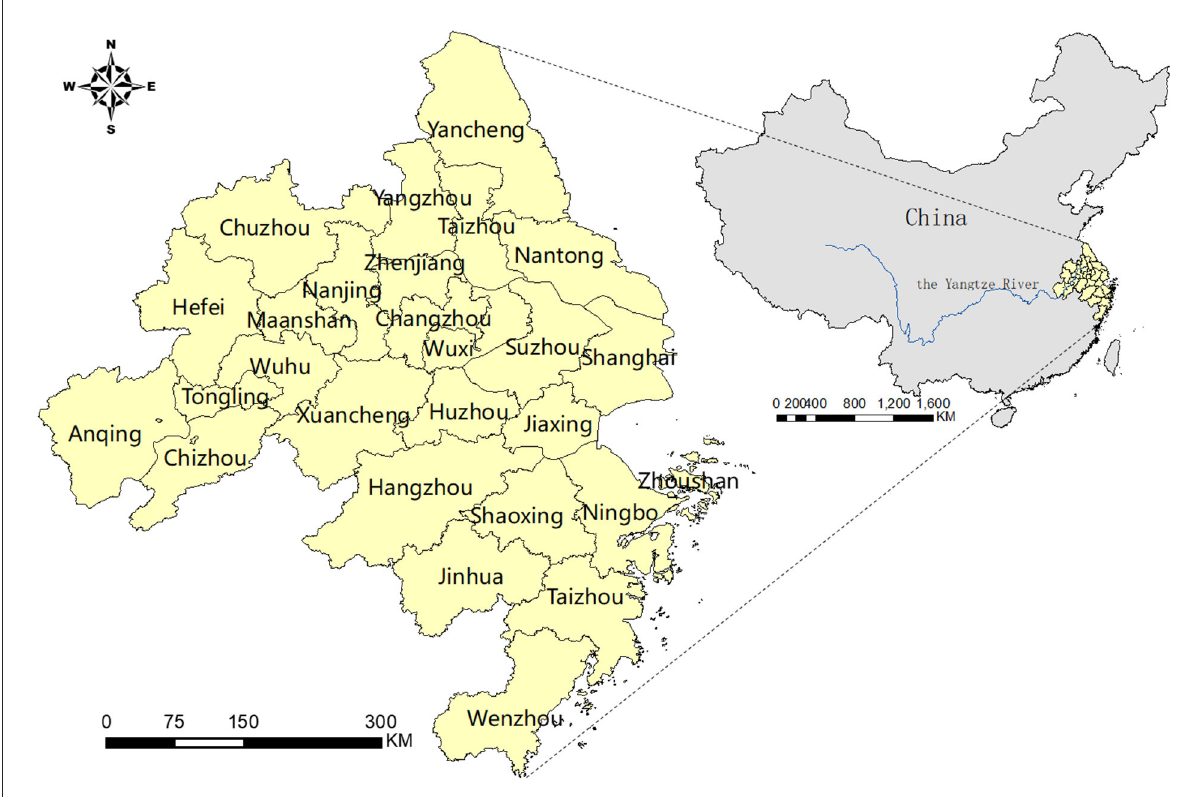
FIGURE1 Geographical location distribution of 27 central cities in